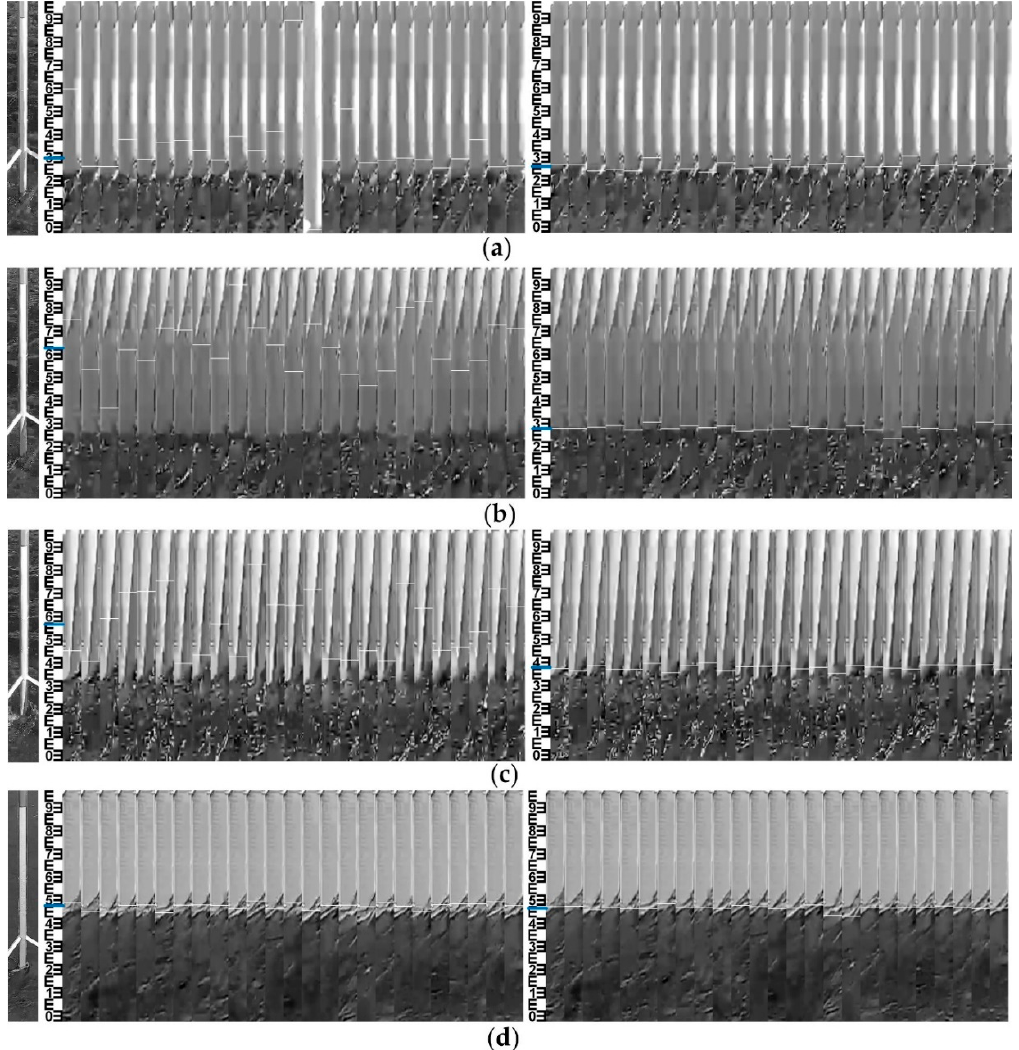
Figure 15. The original water gauge images (left) and visualized OSF (middle) and MMD (right) measurements: ( a ) strong lateral sunlight (09:10:00); ( b ) shadow projection (10:40:00); ( c ) strong direct sunlight (10:50:00); ( d ) high velocity flow (16:40:00).